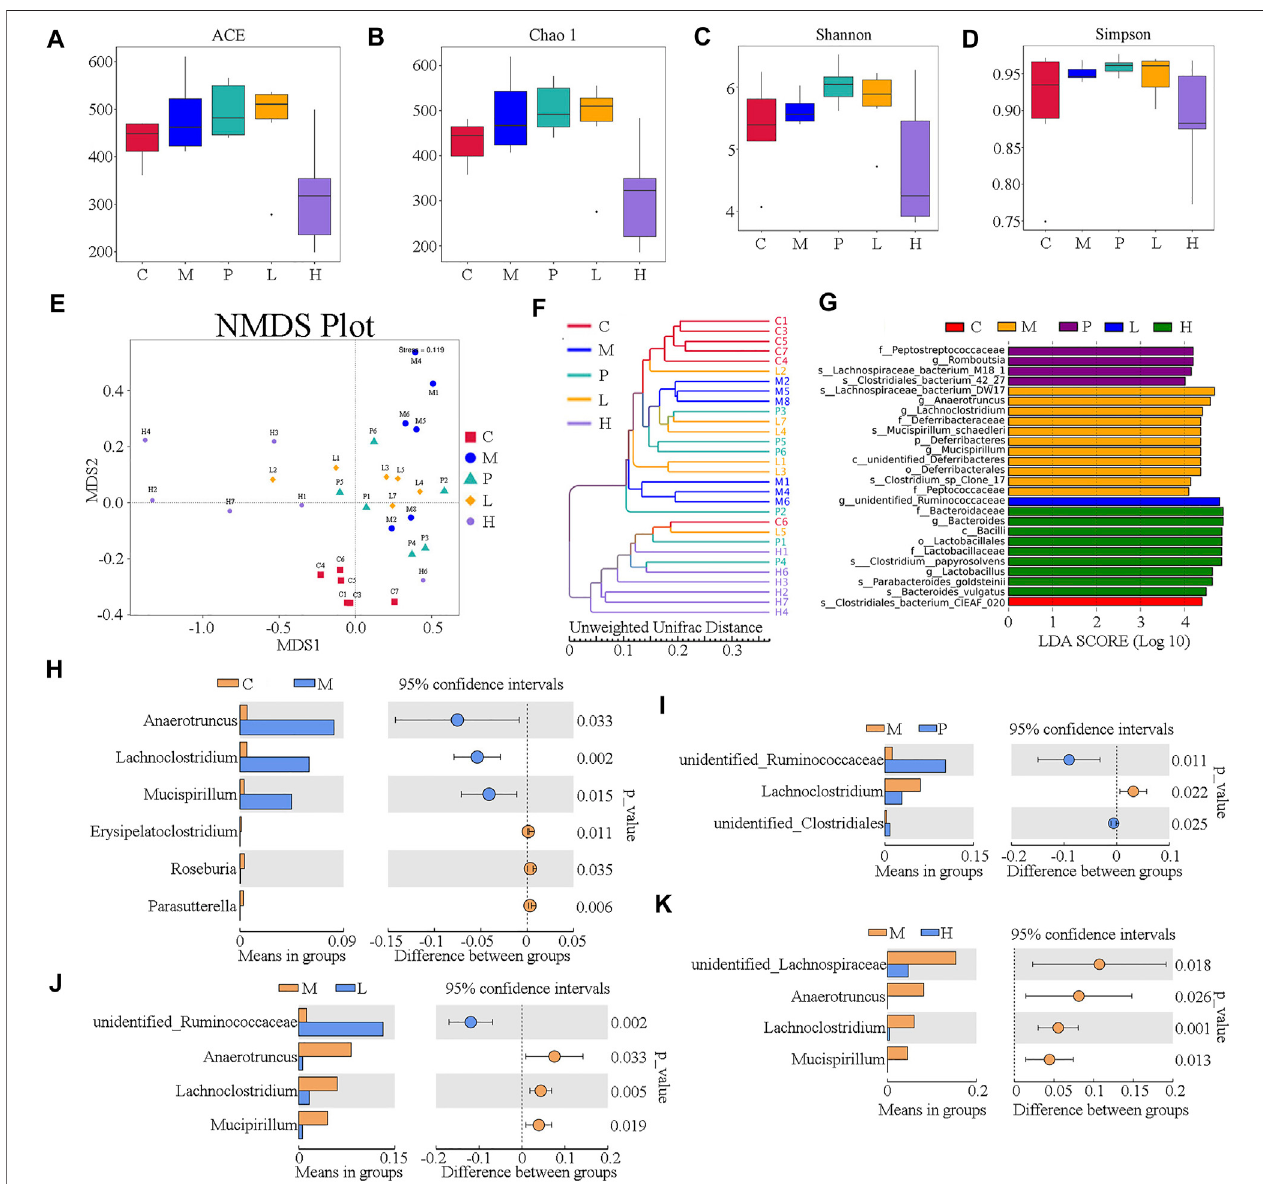
FIGURE 3 | Overall structure of the gut microbiota was modulated after treatment with baicalein ( n = 6). The α -diversity indexes, including ACE, Chao1, Shannon, and Simpson, are displayed in (A – D) , respectively. (E) UniFrac distance-based non-metric multidimensional scaling (NMDS). (F) UniFrac distance-based unweighted pair-group method with arithmetic means (UPGMA) analysis. (G) The score of the linear discriminant analysis (LDA) analysis. (H) STAMP variance analysis are displayed of M vs. C (H) , P vs. M (I,C) , L vs. M (J) , and H vs. M (K) .